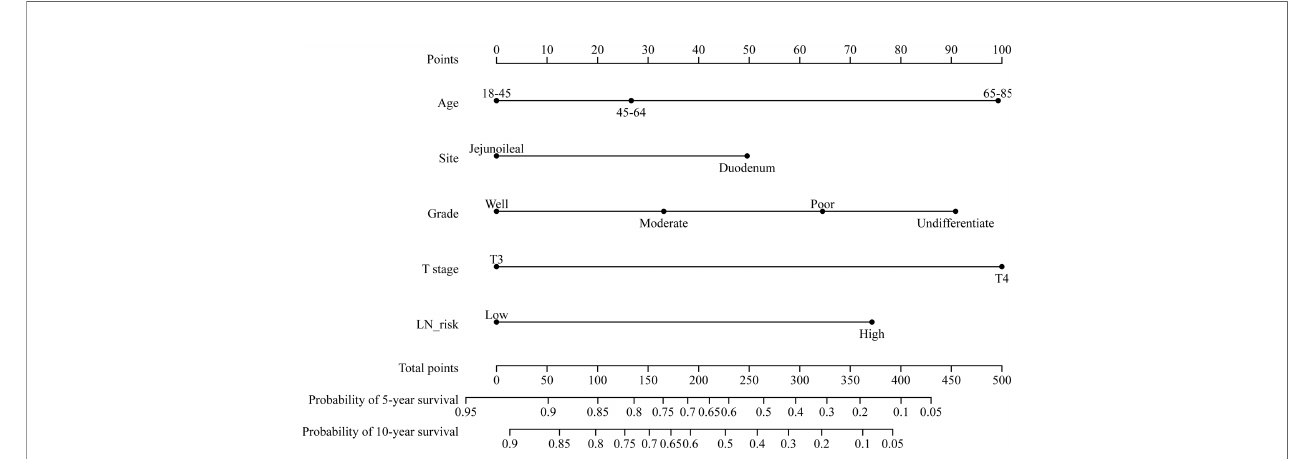
FIGURE 3 | Nomogram predicting the 5- and 10-year cancer-speci fi c survival of patients with stage II small bowel adenocarcinoma. LN risk, lymph